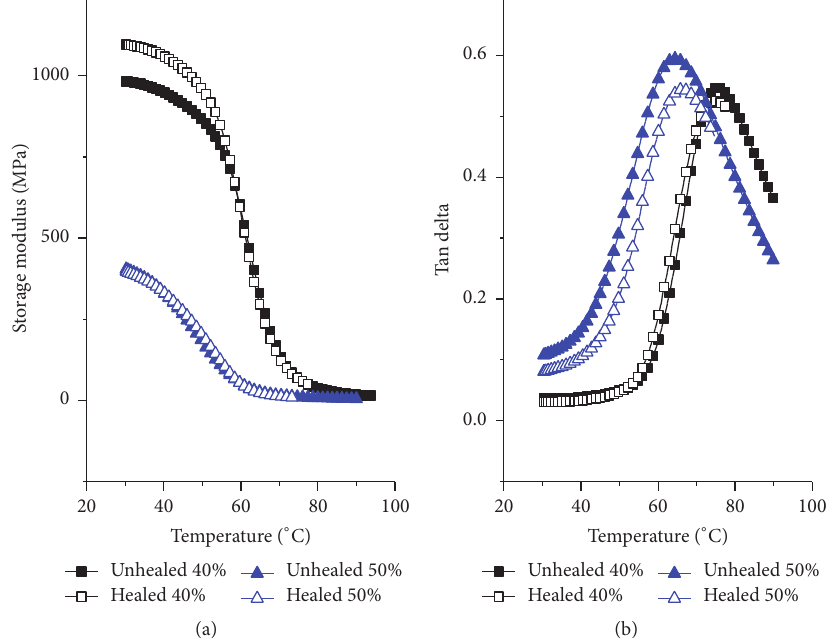
Figure 8: Results of the DMA analysis of the unhealed and healed specimens (a) storage modulus versus temperature and (b) tan delta versus